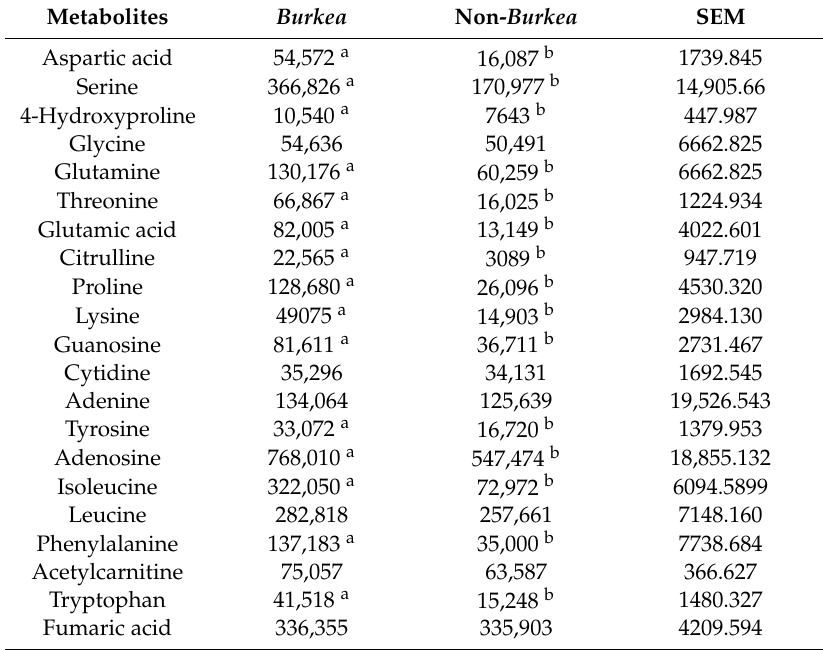
Table 3. Metabolites concentrations detected in Burkea and non-Burkea soils using LC-MS quantification.